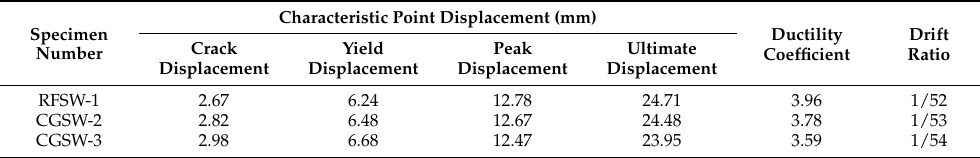
Table 7. Characteristic point displacement and ductility coefficient of the